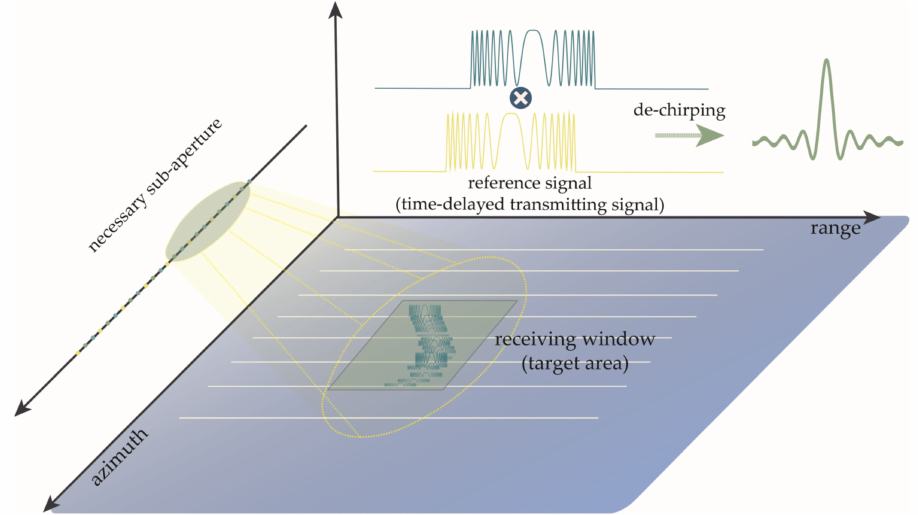
Figure 6. Two-dimensional adaptive receiving by dechirping and subaperture decomposition in the range and azimuth direction, respectively. Only necessary bandwidth and time-length echoes from targets are